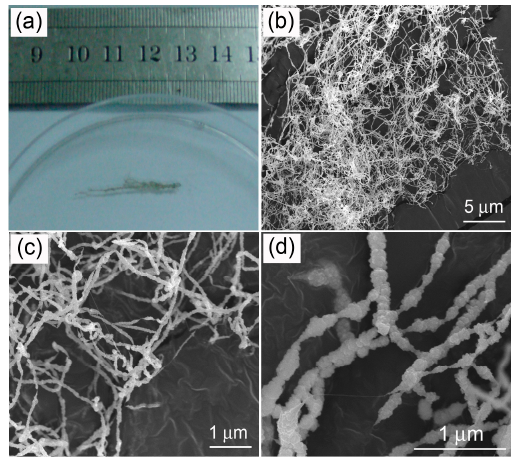
Figure 1. Optical image ( a ) and SEM images of the single-wall carbon nanotube (SWCNT)-ZnS nanocables: low magnification ( b , c ) and high magnification ( d ).